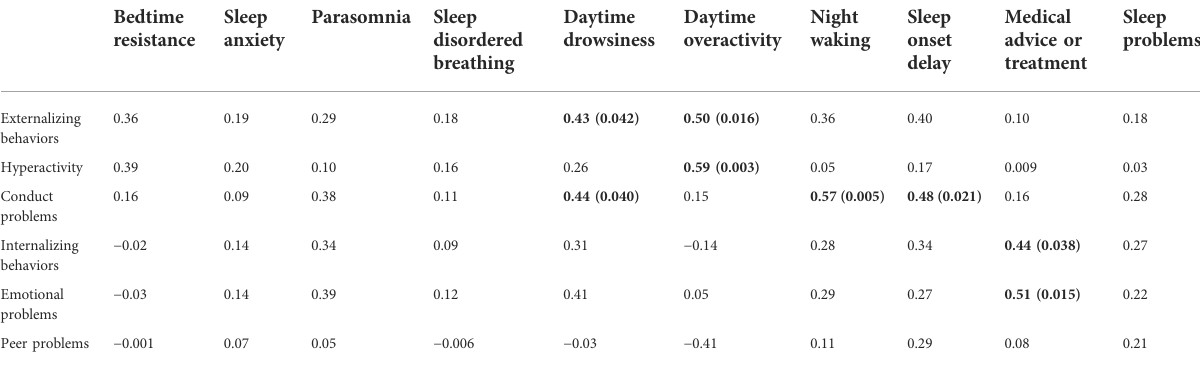
TABLE 4 Bivariate correlations between sleep features and problem behaviors ( N = 22).